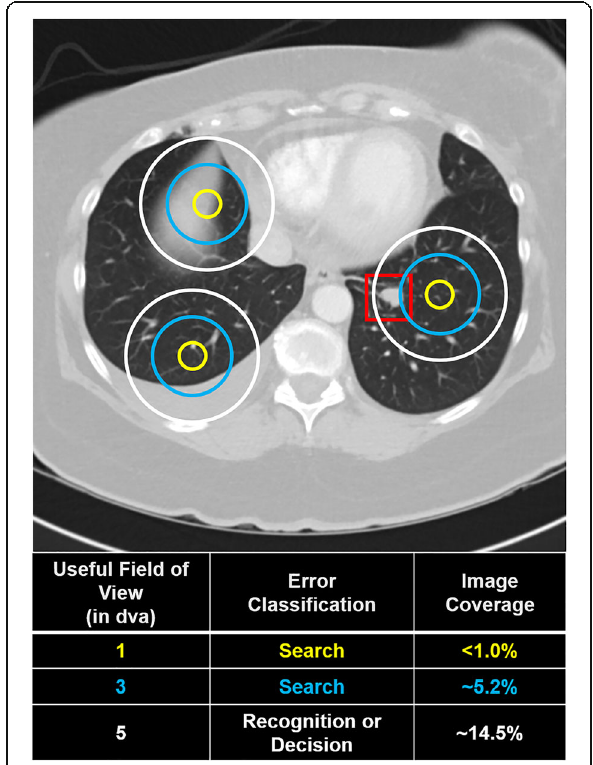
Fig. 5 How useful field of view (UFOV) is defined (in terms of degrees of visual angle (dva)) directly influences the outcome of downstream analyses, such as error classification and image coverage. In this hypothetical example, an observer fixated three times (represented by concentric circles) on an image with a visible lung-nodule (located in the red box) but failed to report it. Using a smaller UFOV, the missed abnormality would be considered a search error. However, it would be classified as a recognition or decision error using the largest UFOV estimate. Similarly, estimated image coverage varies considerably with UFOV size. Critically, the size of the UFOV is both task-dependent and observer-dependent (Drew, Boettcher & Wolfe 2017; Young & Hulleman, 2013; Ebner et al.,